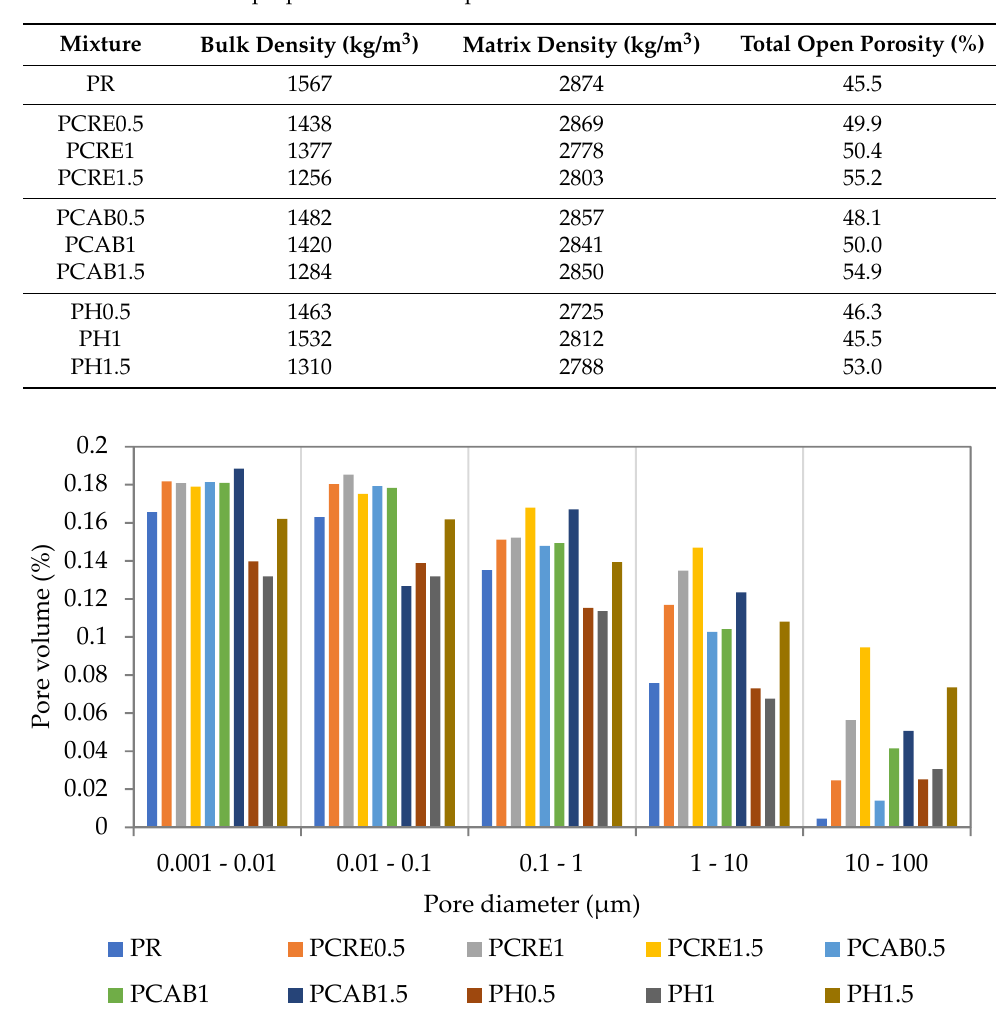
Figure 3. MIP of studied plasters with SAP admixtures.